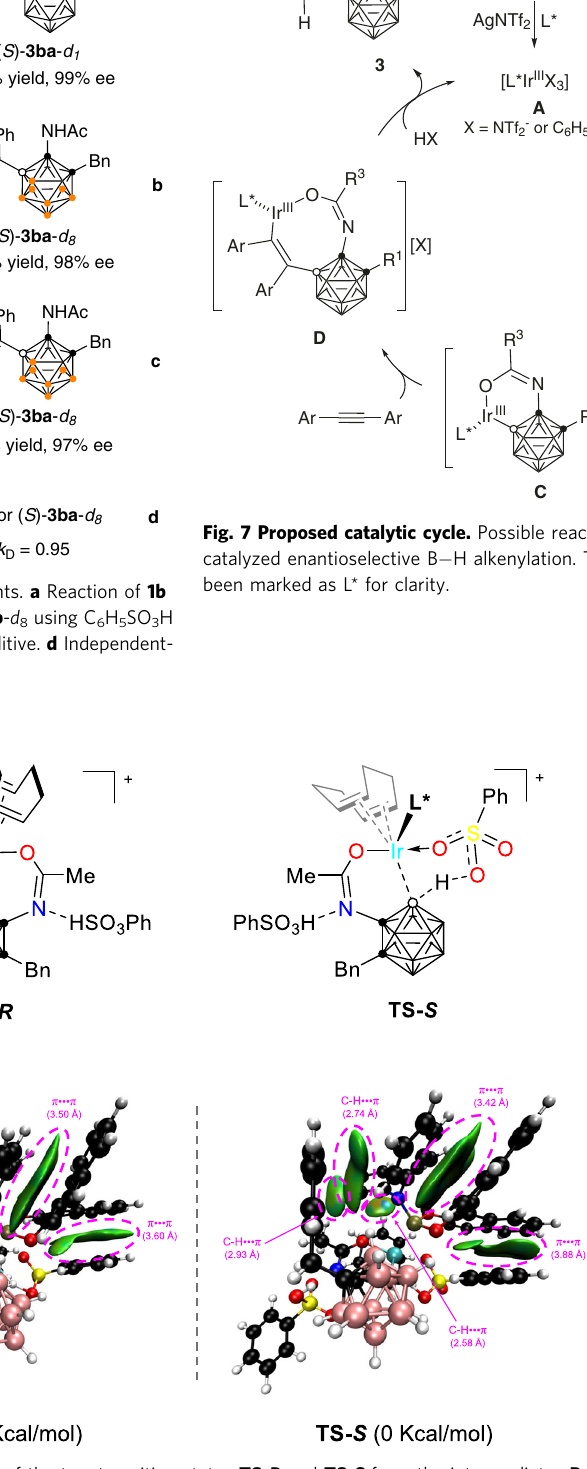
Fig. 8 DFT calculated transition states. a Structures of the two transition states TS- R and TS- S from the intermediates B to C . b NCI analysis for the enantioselective transition states TS- R and TS- S . Values in parentheses are distances between two interactive fragments in